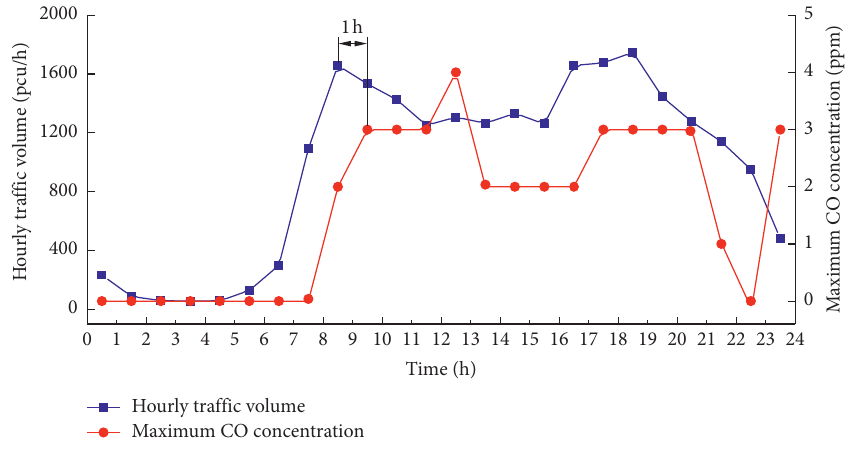
Figure 11: Relative variation of CO concentration and traffic flow in the left bore of Cejiexian Tunnel. Table 5: Maximum CO concentrations and the corresponding measured